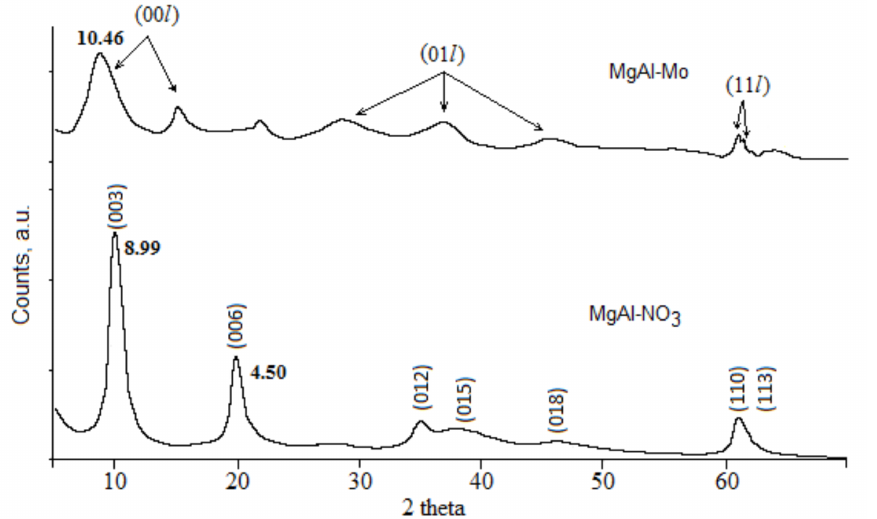
Figure 7. XRD patterns of Mo- and NO 3 -MgAl-LDH. Adapted from ref. [113], used with permission. Copyright 2012 Elsevier.